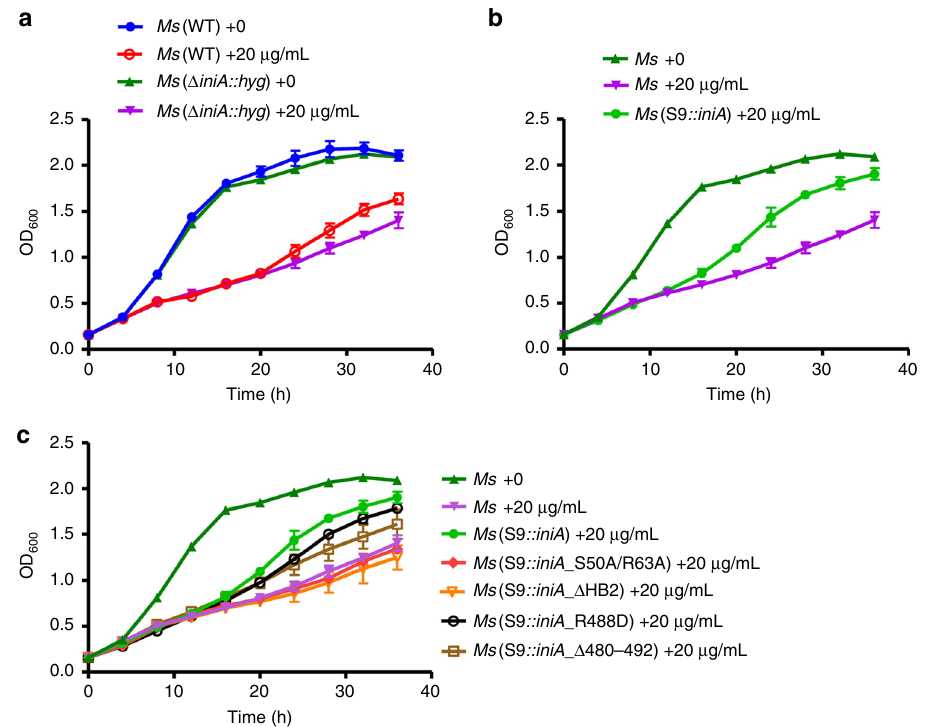
Fig. 7 IniA-mediated isoniazid resistance in M. smegmatis . a Growth curves of wild-type M. smegmatis [ Ms (WT)] and iniA- deleted strain [ Ms ( Δ iniA::hyg )] in the presence or absence of 20 μ g mL − 1 isoniazid. b Growth curves of Ms ( Δ iniA::hyg ) with overexpression of wild-type IniA (S9:: iniA ) in 20 μ g mL − 1 isoniazid, compared with no antibiotics or no IniA overexpression. c As shown in ( b ), overexpression of mutant IniA, including S50A/R63A, Δ HB2, R488D, and Δ 480 – 492. Each bar is the mean and SD of three measurements. The source data of Fig. 7a – c are provided in the Source Data fi